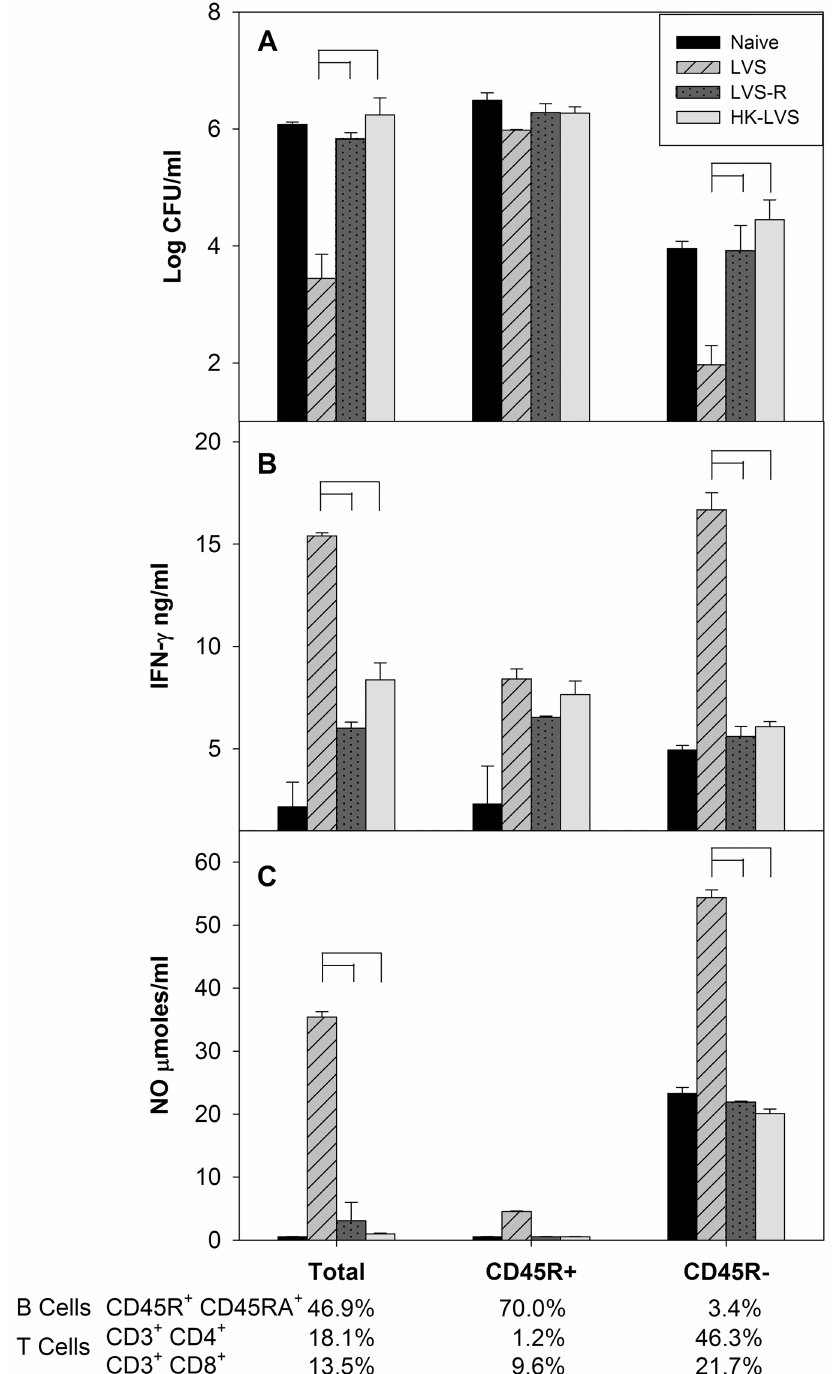
Fig 3. Control of intramacrophage LVS growth depends on T cells but not B cells. BMM F from Fischer 344 rats were infected with LVS and co-cultured with total, CD45R + (B lymphocytes) or CD45R - splenocytes (non-B lymphocytes) obtained from naïve or vaccinated Fischer 344 rats, as indicated. Splenocytes were analyzed by flow cytometry to evaluate purity of B and T cells, as indicated. After three days of co-culture, BMM F were lysed to evaluate the recovery of intracellular bacteria (Panel A). Supernatants were collected for analyses of IFN- γ by ELISA (Panel B) and NO by Griess reaction (Panel C), and their concentrations were calculated using standard curves as references. Values shown are the mean concentration ± standard deviation of triplicate wells. Brackets indicate significant differences between the indicated groups ( P < 0.05). Data shown are from one representative experiments of two of similar design and